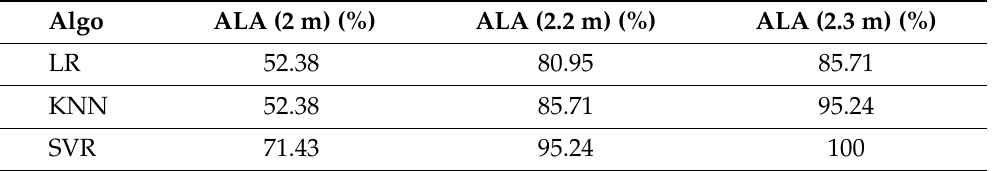
Table 6. Average LA (ALA) with different d max values for 21